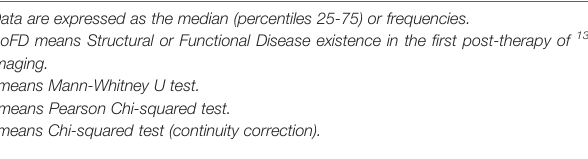
TABLE 2 | Comparison of response to initial RAT between 2 groups [n (%)].